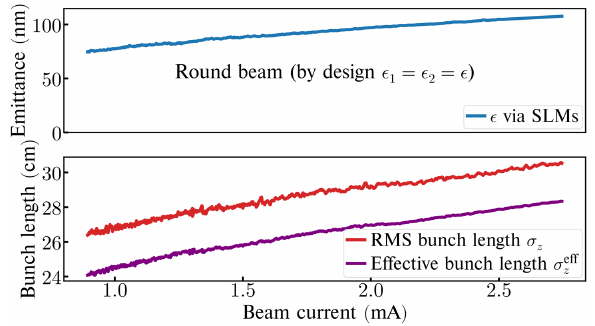
FIG. 2. Mode emittances ( ϵ 1 ¼ ϵ 2 ¼ ϵ ) and bunch lengths (rms and effective) of a round beam in IOTA as functions of beam current. SLMs had a monitor-to-monitor variation of (cid:3) 8 nm (not shown) in the measurement of ϵ